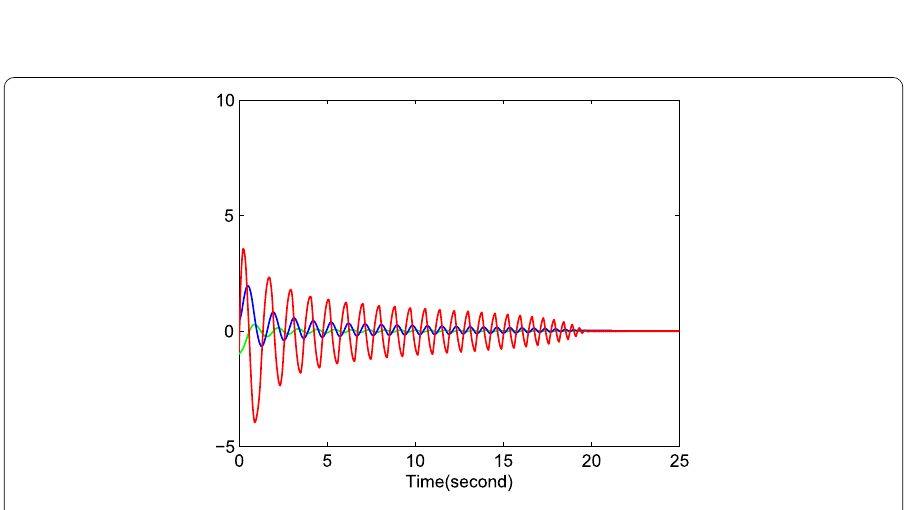
Figure 7 The convergency trajectory: e 1 ( t ) (green line), e 2 ( t ) (blue line), and e 3 ( t ) (red line)